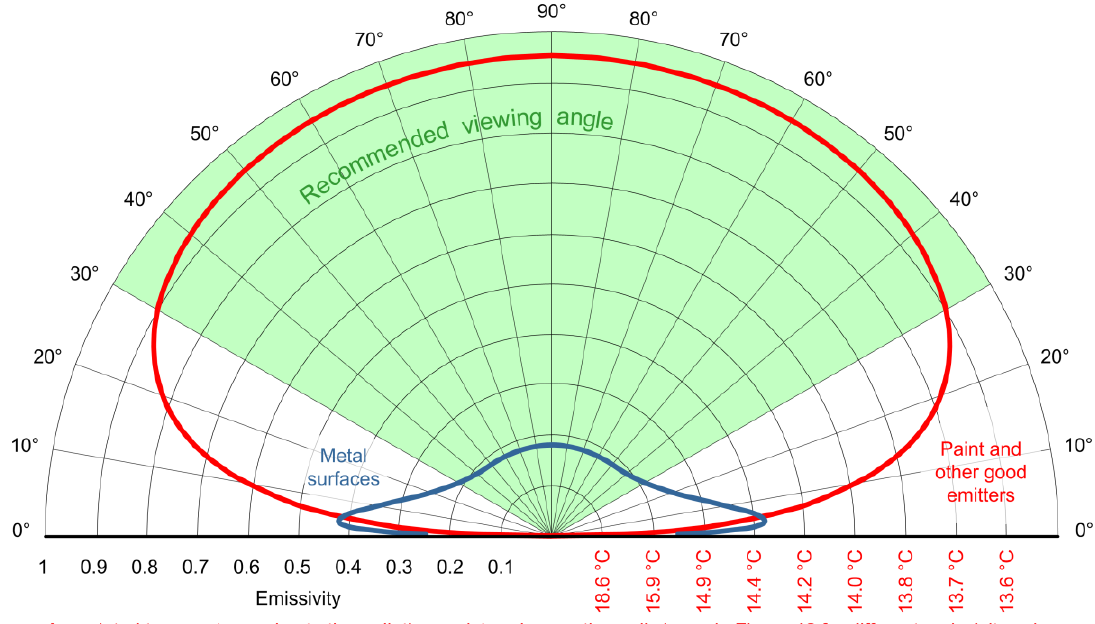
Figure 18. Polar diagram of directional spectral emissivity of the object and influence of emissivity changes on the temperature displayed by the thermal camera Flir E60bx.